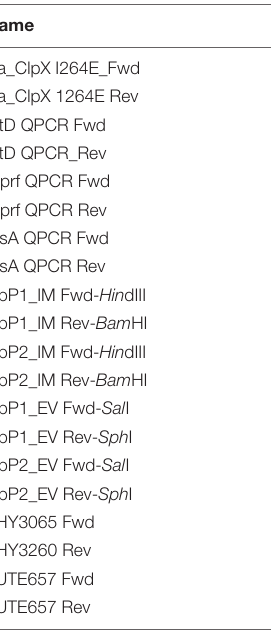
TABLE 1 | Primers used in the